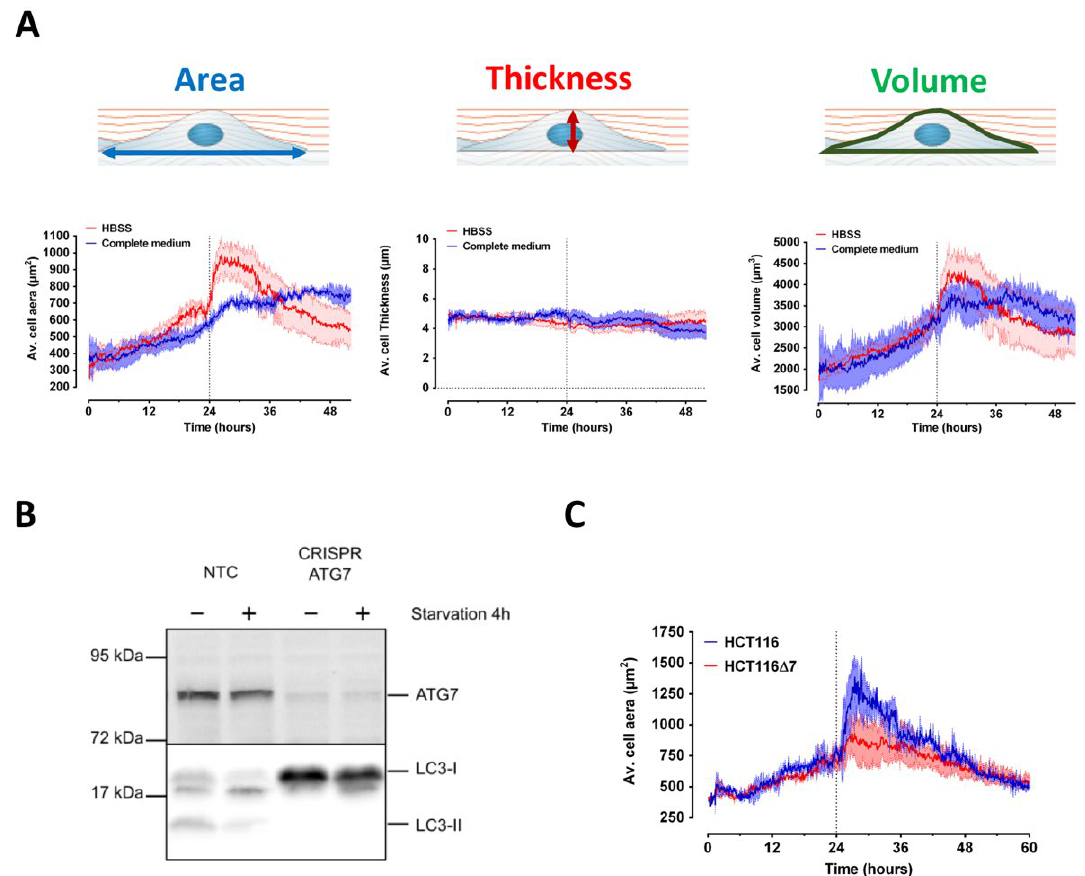
Figure 4. Effect of serum deprivation-induced autophagy on HCT116 cells area, thickness, and volume assessed by DHM. ( A ) HCT116 cells were left in culture for 24 h before the culture medium was either refreshed or replaced with HBSS serum-free medium at the time indicated with a vertical dashed line. DHM measurement of HCT116 cells area (left column), thickness (middle column), or volume (right column) was performed throughout the experiment that lasted up to 55 h. The data represents average of three to four independent experiments ± SEM values. ( B ) Functional validation of autophagy-deficient HCT116 cells: HCT116 cells transduced with non targeting sg-RNA (NTC) or with ATG7 sg-RNA (CRISPR-ATG7) were grown in complete medium or transferred to HBSS for 4 h (serum deprivation induced autophagy). The efficiency of ATG7 gene edition was verified by western blot on the top panel (Cell Signaling Rabbit monoclonal antibody D12B11). The absence of lipidation of the autophagy protein LC3-I into PE-conjugated LC3-II in HCT116-CRISPR-ATG7 cells confirms that autophagy was functionally impaired in these cells compared to NTC cells (bottom panel—Sigma anti-LC3B rabbit antibody L7543). ( C ) HCT116 or HCT116-CRISPR-ATG7 cells were left in culture for 24h before the culture medium was replaced with HBSS serum-free medium at the time indicated with a vertical dashed line. Cells area was measured throughout the experiment using DHM. The data represents the average of three independent experiments ± SEM values.